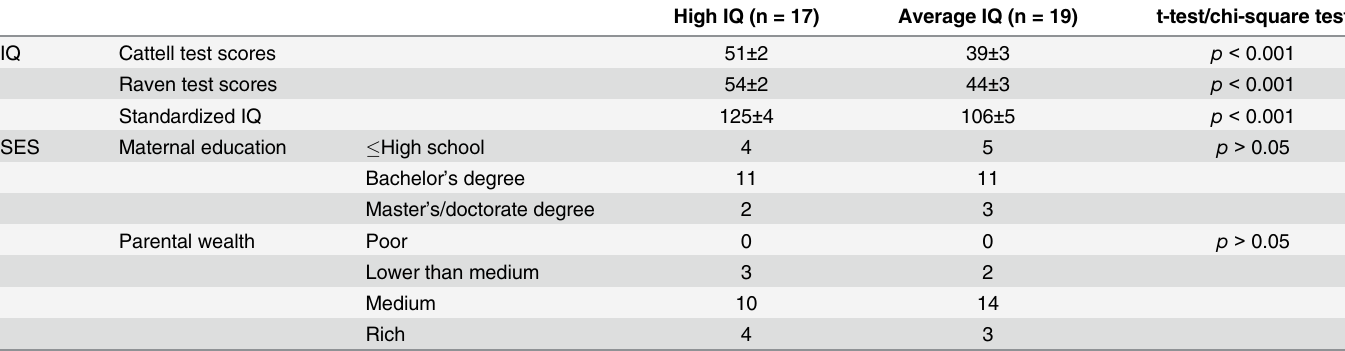
Table 1. Participants ’ means and standard deviations of IQ scores and SES characteristics.